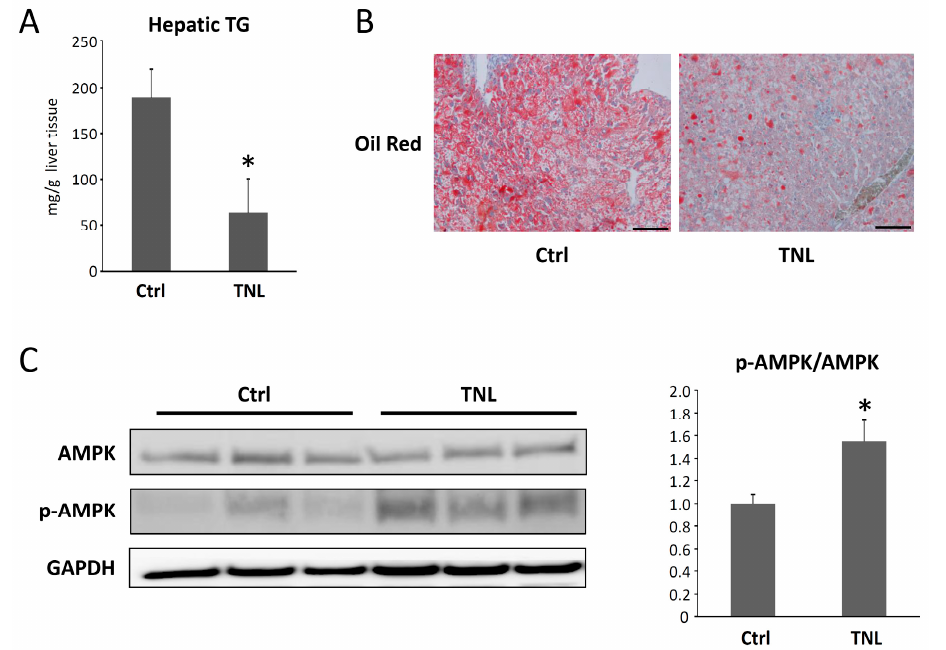
Figure 2. Effects of teneligliptin on hepatic steatosis and the levels of AMPK and p-AMPK in the livers of experimental mice. ( A ) Hepatic lipids were extracted from liver samples, and intrahepatic triglyceride (TG) levels were measured ( n = 6); ( B ) steatosis in frozen liver sections from experimental mice treated with or without teneligliptin was analyzed with Oil Red O staining. Bar, 100 μ m; ( C ) Total proteins were extracted from the livers of experimental mice, and the expression levels of AMPK and p-AMPK proteins were examined by Western blot analysis using the respective antibodies. GAPDH served as a loading control ( left panel). Band intensities were quantified using densitometry. After the average of band intensity ratios of p-AMPK to GAPDH and AMPK to GAPDH were calculated in each sample, the ratios of these calculated values, which was expressed as p-AMPK/AMPK, were determined ( right panel). Similar results were obtained in repeat experiments. The values are expressed as the mean ± SD. * p < 0.05 versus the control group.